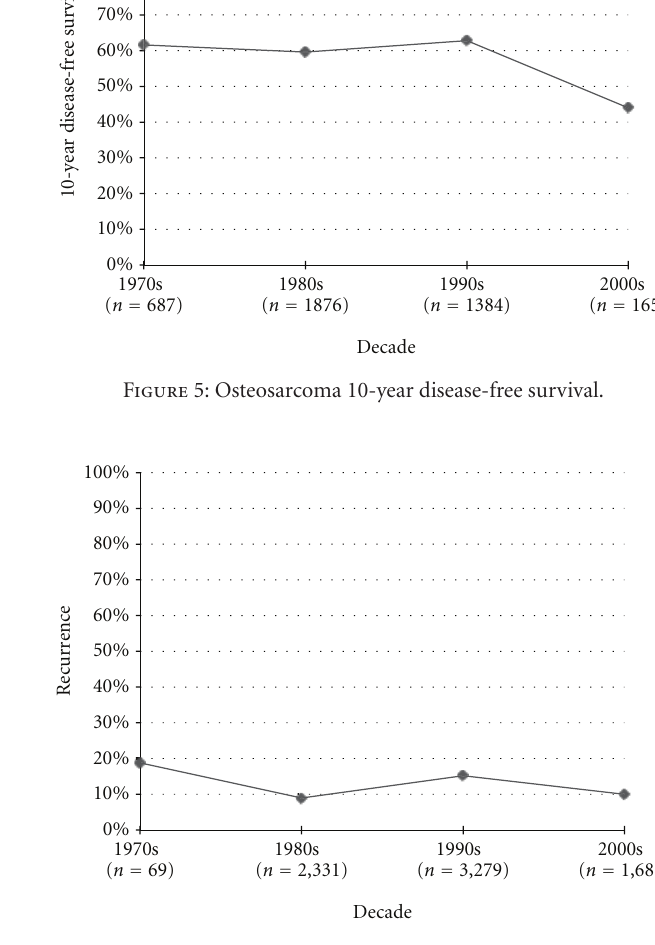
Figure 6: Osteosarcoma recurrence